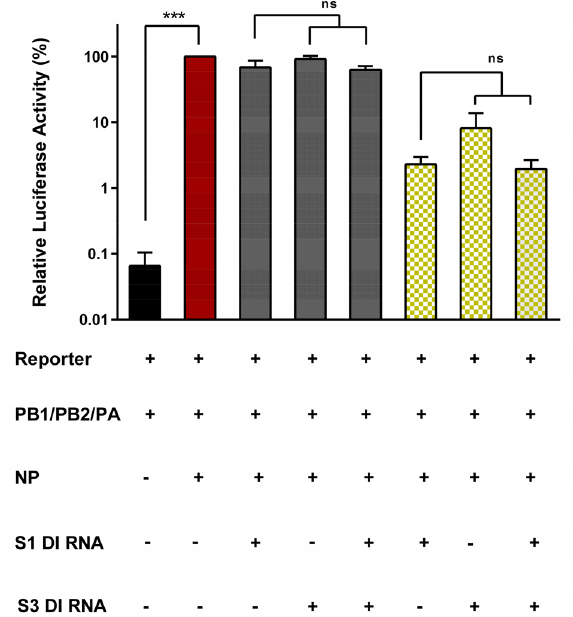
Figure 3. The presence of two DI RNAs does not increase inhibition of genome replication. 293T cells were cotransfected with the indicated combinations of plasmids encoding the viral polymerase proteins, NP, a segment 8-based luciferase reporter and the indicated DI RNAs at 10 (gray bars) and 300 ng (green checkered bars). Luciferase activity was determined at 24 h posttransfection. The results of single round DI RNA induced replication inhibition are shown. The average of three independent experiments is shown. Error bars indicate SEM. Two tailed paired student t-test was used to assess statistical significance. p < 0.005 = ***, ns: not